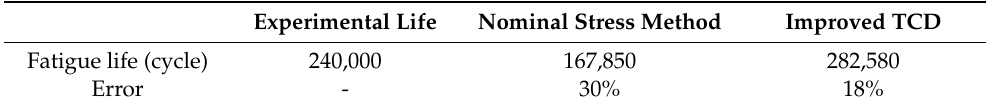
Table 9. Comparison of fatigue life